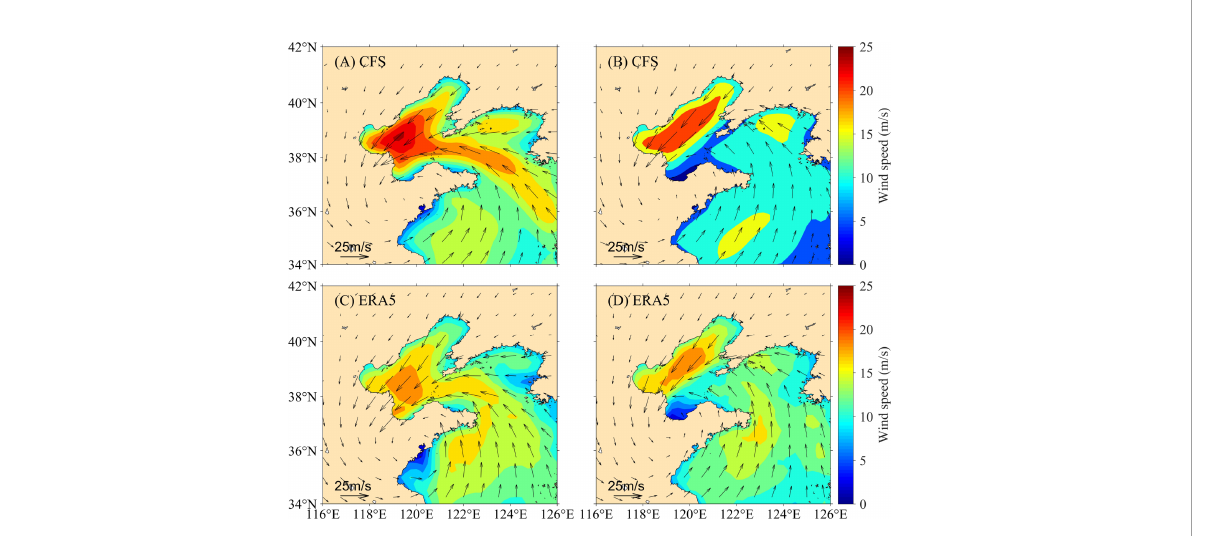
FIGURE 3 Comparisons of wind fi eld snapshots between CFS and ERA5 at 12:00 (UTC) on August 11, 2019 (A, C) and at 18:00 (UTC) on August 11, 2019 (B, D) during TY1909.